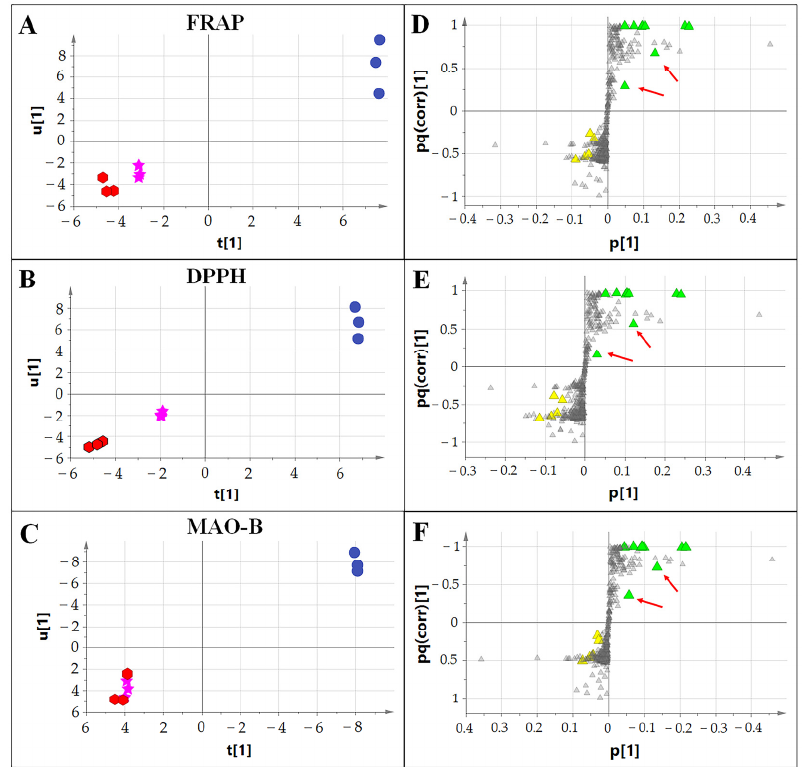
Figure 7. OPLS analysis showing correlation between the metabolites, antioxidant capacity and MAO-B activity of different extracts. ( A – C ) are the score scatter plots of the FRAP, DPPH and MAO-B assays, respectively. Red hexagons indicate pseudobulb samples, pink stars the flowers and blue circles the leaves. ( D – F ) are the loading plots of the FRAP, DPPH and MAO-B assays, respectively. Triangles indicate the metabolites. Yellow triangles are chrysin derivatives in which the acyl group (syringic or gallic acid) is linked to the deoxyhexose of the C-diglycoside (Ac in Figure 5). Green triangles indicate those chrysin derivatives with gallic, methylgallic or caffeic acid attached to the O -glycoside (R in Figure 5). The red arrows indicate the two chrysins including methylgalloyl residues attached to the O -glycoside.